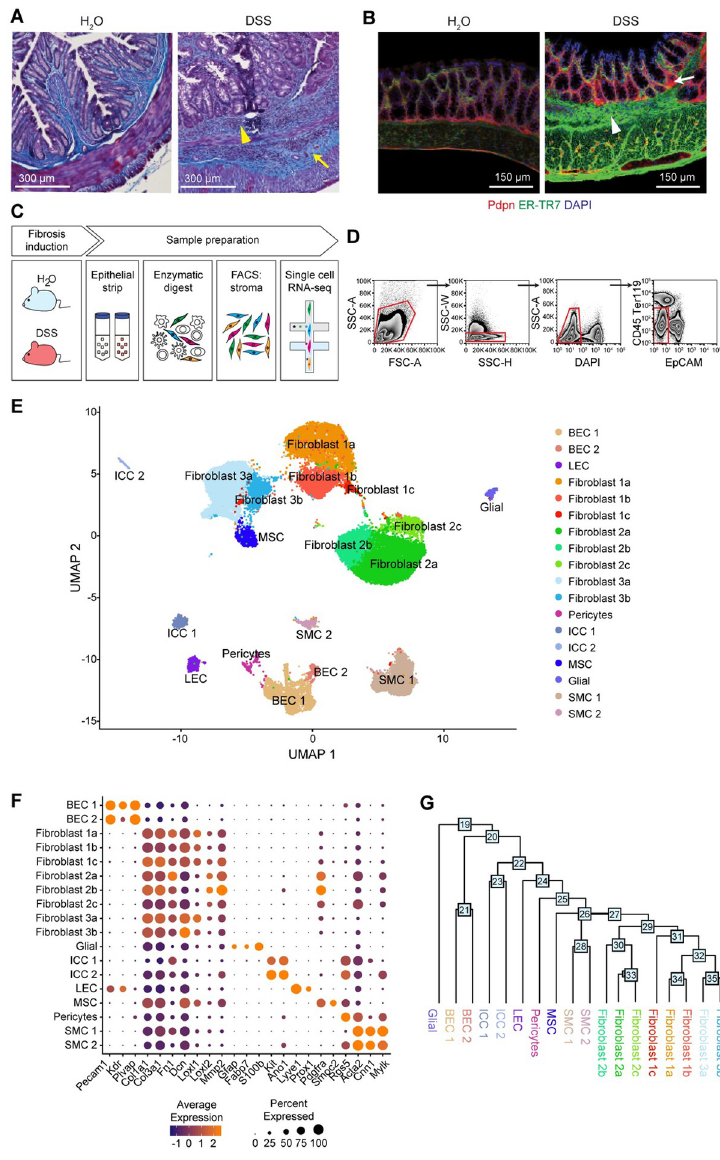
Fig 1. A cellular census of stromal cells in healthy and inflamed mucosal tissues. (A) Masson’s trichrome staining of colon from water- and chronic DSS (3 rounds)-fed mice. Collagen accumulation in blue, as demarcated by yellow arrows. Leukocyte infiltrates, as demarcated by yellow arrowheads. n = 2, Scale bar, 300 μ m. representative of 2 experiments. (B) IF staining of colon from water- and chronic DSS-fed mice. DAPI (blue), Pdpn (red), ER-TR7 (green). ECM deposition, as demarcated by white arrowhead. Pdpn + cell expansion, as demarcated by white arrow. Scale bar, 150 μ m. n = 3. (C) Workflow depicts colon processing, epithelial strip, mechanical and enzymatic digestion dissociation, and sorting to enrich for stromal cells. (D) Gating strategy for FACS to enrich for colon stromal cells (DAPI − CD45 − Ter119 − EpCAM − ) prior to performing single-cell transcriptomics. (E) Single-cell atlas of the murine colonic stroma. UMAP of approximately 34,000 single-cell (dots) profiles colored by cell type assignment. (F) Expression of common stromal marker genes across cell type subsets. Color represents average expression of marker gene within clusters; diameter represents percentage expression of marker gene within cluster. (G) A dendrogram of cell subset relationships based on the single-cell transcriptomic data. Numbers at nodes represent score of how closely related the clusters are, with the higher the number indicating transcriptional similarity. DSS AU : AbbreviationlistshavebeencompiledforthoseusedinFigs 1 (cid:0) 6 : Pleaseverifythatallentriesarecorrect : , dextran sulfate sodium; ECM, extracellular matrix; IF, immunofluorescence; UMAP, uniform manifold approximation and projection.